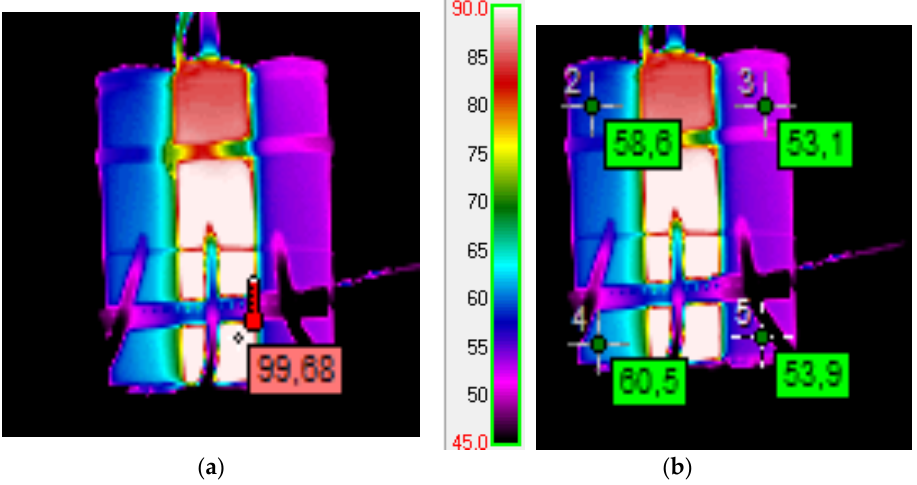
Figure 4. Thermogram of two cells and a heater. ( a ) Heater temperature measurement. ( b ) Comparison of cell temperatures; discharged cell on the right (results in degrees Celsius).